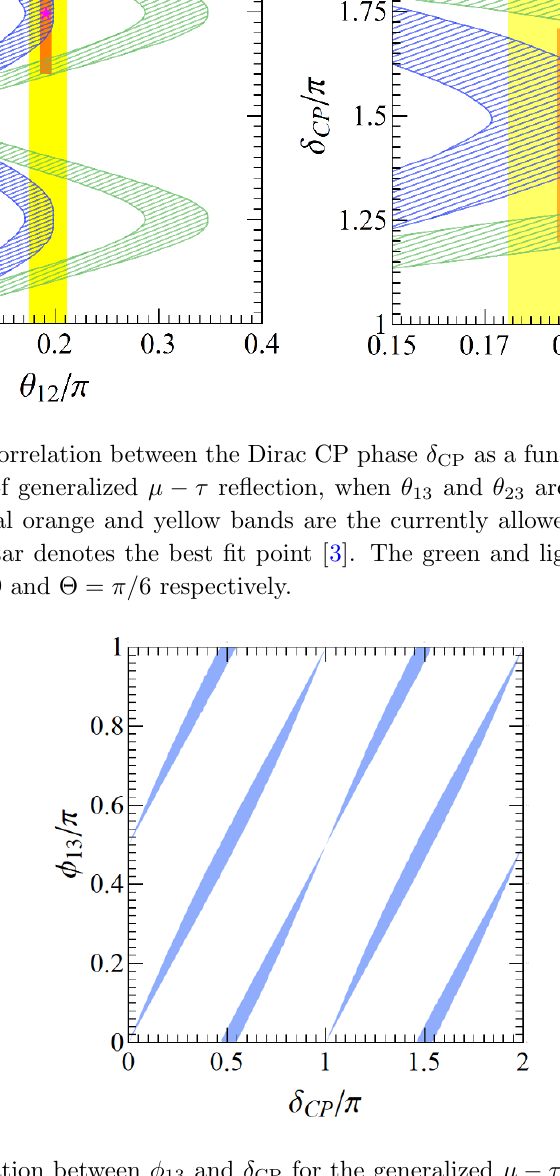
Figure 7 . The correlation between (cid:30) 13 and (cid:14) CP for the generalized (cid:22) (cid:0) (cid:28) re(cid:13)ection acting on the charged lepton sector, taking (cid:12) = (cid:13) = 0 and the three mixing angles in their 3 (cid:27) regions